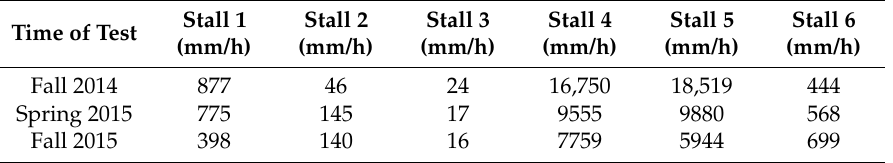
Table 2. Surface infiltration rates (SIR) of the six stalls during monitoring period.